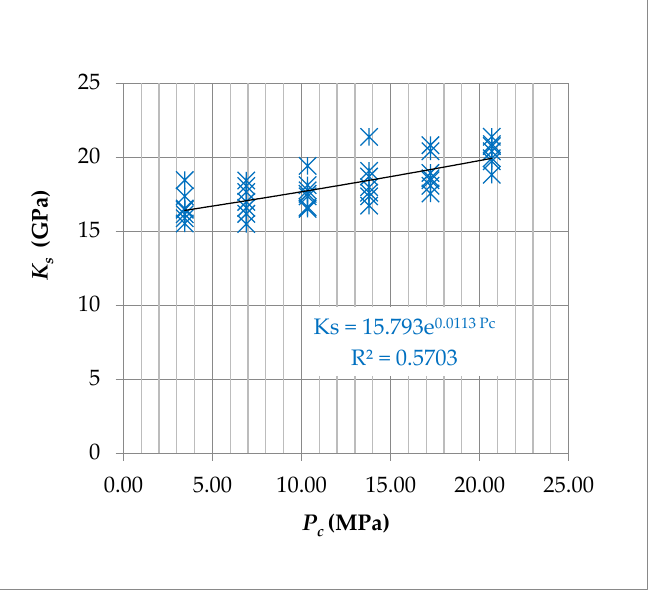
Figure 5. Calculated 𝐾 𝑠 as a function of the hydrostatic stress (Method 1).